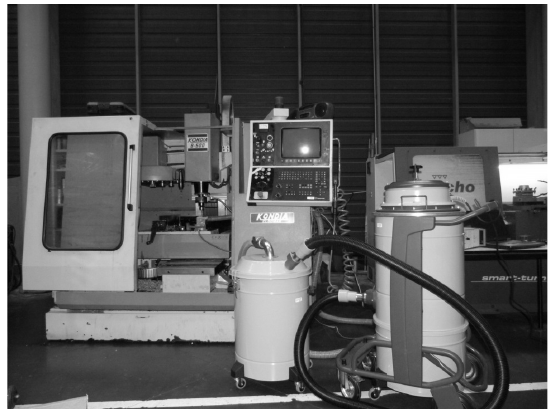
Figure 3. Machining center used in the experiments was equipped with the dynamometer, acquisition system and also with a system for chip